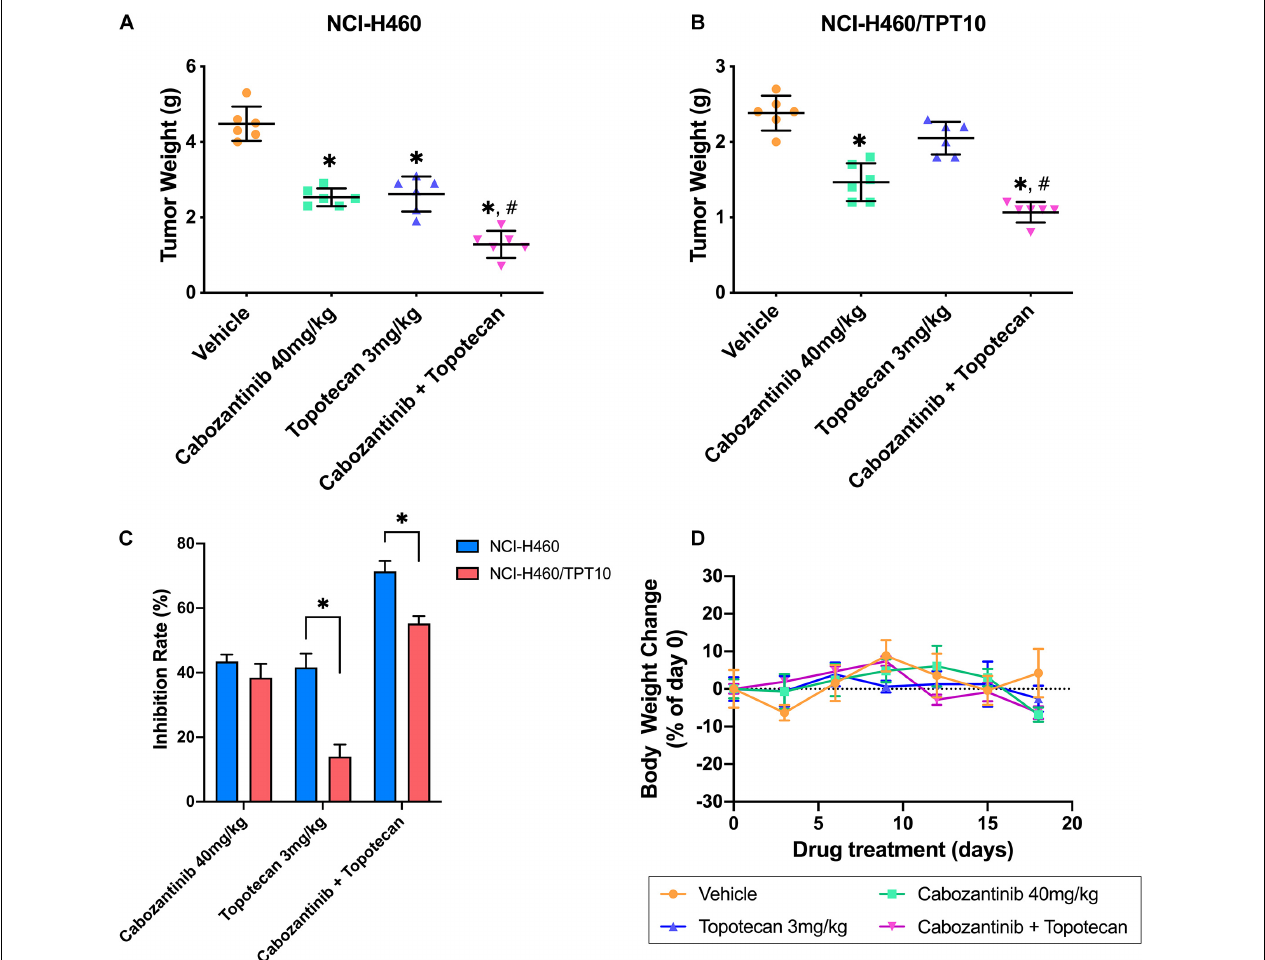
FIGURE 5 | Changes of the tumor weight and the body weight in xenograft mouse model. (A,B) Scatter points represented the weights of the excised NCI-H460 tumors and NCI-H460/TPT10 tumors at the end of the 18-day treatment period ( n = 6 per treatment group). Lines and error bars represented the mean weight values and SD. ∗ p < 0.05 versus the vehicle group; # p < 0.05 versus the topotecan group. (C) The inhibitory rates of the treatment were demonstrated as the columns with different treatments. IR = 1 – (Mean tumor weight of experimental group/Mean tumor weight of vehicle control group) × 100%. Columns and error bars represented mean and SD. ∗ p < 0.05. (D) Body weight changes during the treatment period. Data points and error bars represent the mean and SD of body weight change represented by the percentage of the body weight at day 0 ( n =